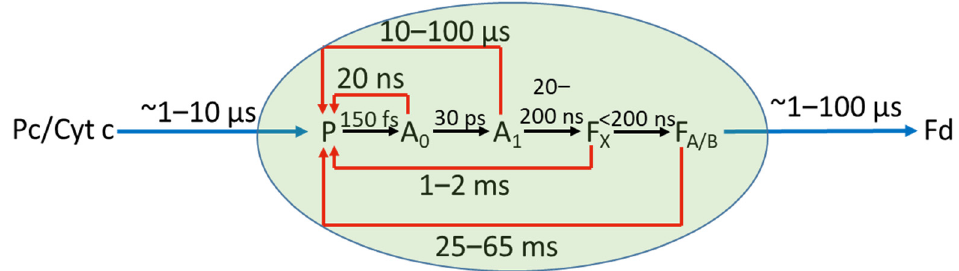
Figure 1. Scheme of ET reactions inside PSI complex and between PSI and natural external electron donor (plastocyanin, Pc, or cytochrome c , Cyt C) and acceptor (ferredoxin, Fd). Forward ET reactions are represented by black arrows and are completed (the state P + F A/B − is formed) in a submicrosecond time range [8]. Backward ET reactions are represented by red arrows, and ET between PSI and external carriers—by blue arrows. For simplicity, the two branches of initial ET cofactors were lumped together into one. Moreover, two final electron acceptors, F A and F B , are lumped together into one, F A/B .